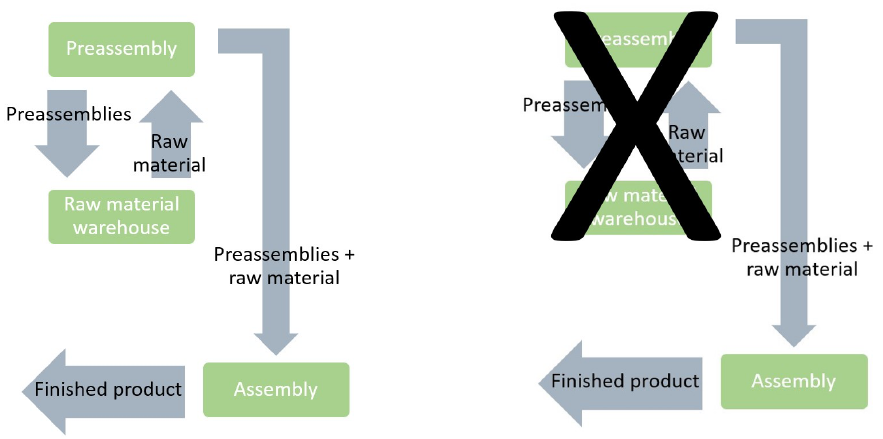
Figure 11. Logistics process with (“as-is”, left ) and without (“to-be”, right ) the pre-assemblies. The saved times in the logistic operations area are summarised in Table